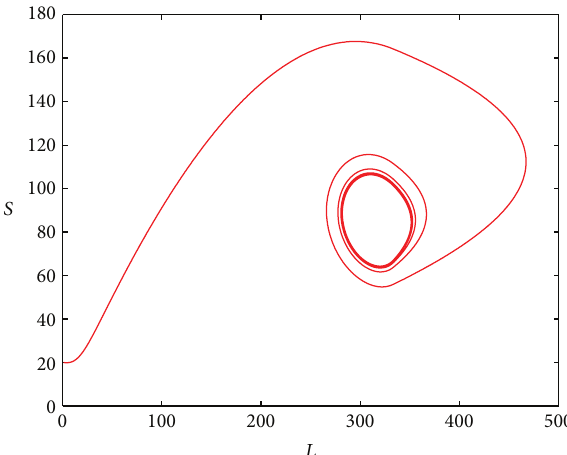
Figure 3: Phase portrait of 𝐿 versus 𝑆 . The existence of a periodic solution for model (1) is evident. Parameters values are the same as of Figure